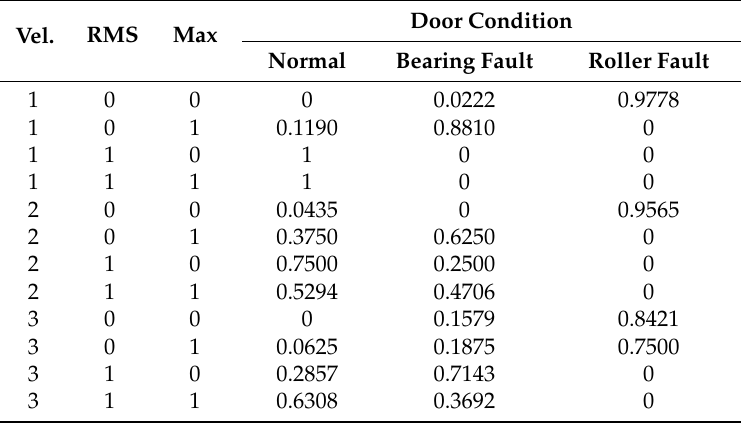
Table 4. Conditional probability table during the close operation.